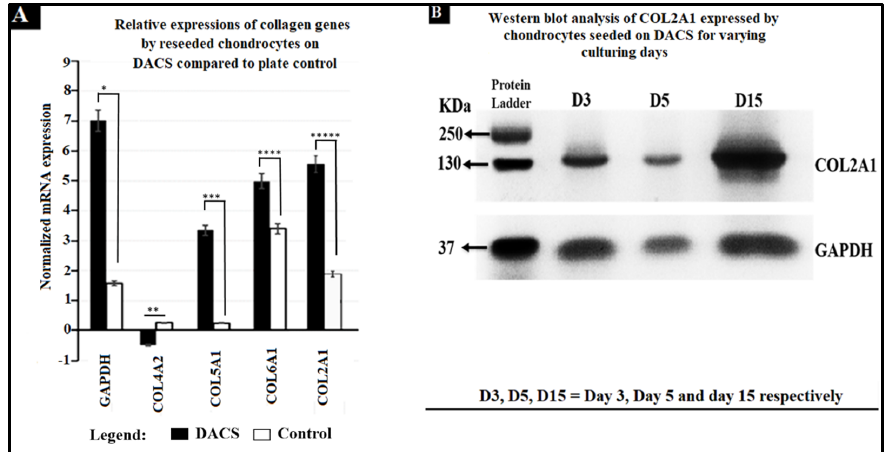
Figure 14. Relative expression of collagen genes of chondrocytes seeded on DACS scaffold compared to the plate control and western blot analysis of Col2A1 of chondrocytes seeded on DACS construct. ( A ) Collagen 2A1, 5A1, 6A1 up-regulated in chondrocytes grown in 3D DACS scaffold, and Collagen 4A2 was observed to be downregulated. ( B ) Shows the western blot analysis of Col2A1 protein expressed by chondrocytes seeded on DACS scaffold at various days of culturing. These molecules drive chondrocytes remodeling of scaffold ECM, ECM formation and deposition, and play a crucial role in adhesion. Relative expression of collagen genes of chondrocytes seeded on DACS scaffold compared to the plate control. Data were pooled from three independent experiments, and error bars show mean ± SEM. Significance was determined by Student t -test, two tails, with p < 0.01 determined for all. N = 3. * p -value < 0.001, ** p -value = 0.0524, *** p -value < 0.001, **** p -value = 0.0046, ***** p -value < 0.001.